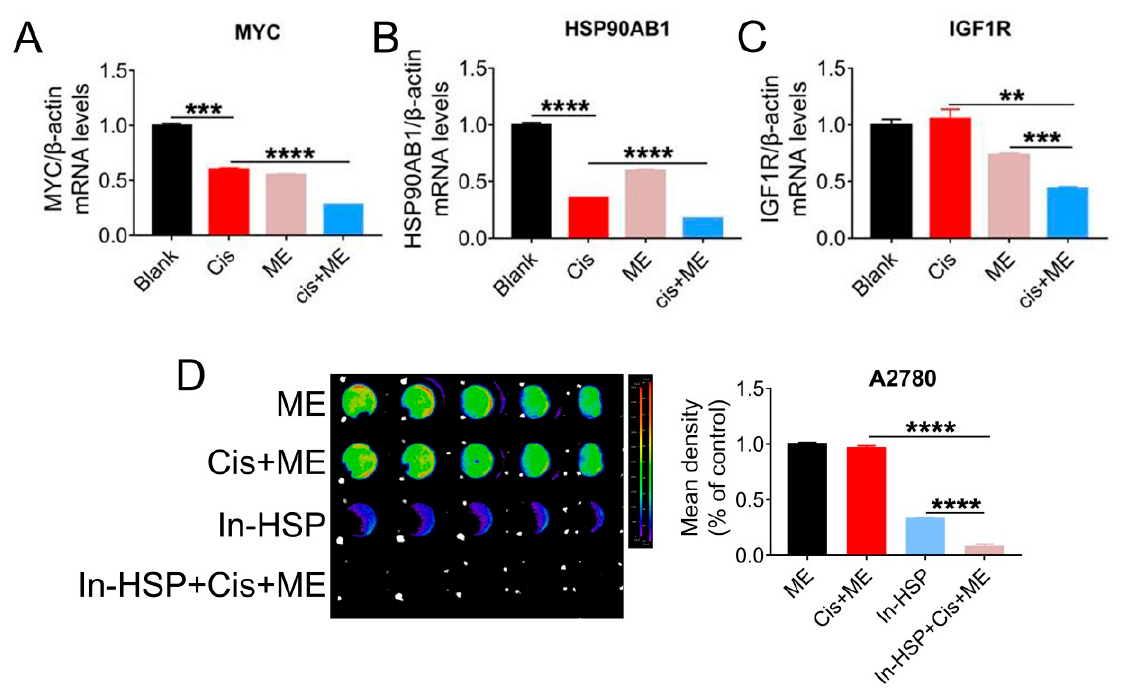
Figure 5. HSP90 ATPase inhibition with geldanamycin enhances the pro-apoptosis effect of ME in ovarian cancer cells. SKOV3 cells were treated with 3.2 μ g/mL cisplatin and 6 mg/mL ME for 48 h. The mRNA levels of ( A ) MYC, ( B ) HSP90AB1, and ( C ) IGF1R were measured by real-time PCR. ( D ) The luciferase positive A2780 were analyzed using Living Image software and a GloMax ® 96-microplate luminometer. The quantification of luciferase-positive cells is indicated on the right. Three independent experiments were performed with similar results. Data are shown as mean ± SEM. ** p ≤ 0.01, *** p ≤ 0.001, **** p ≤ 0.0001.